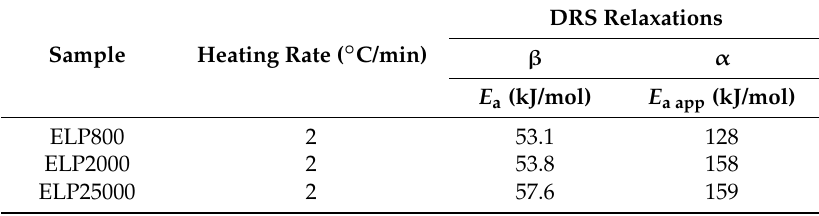
Table 4. Activation energy results obtained from dielectric spectroscopy (DRS) for fully cured ELP800, ELP25000, and ELP2000 samples.